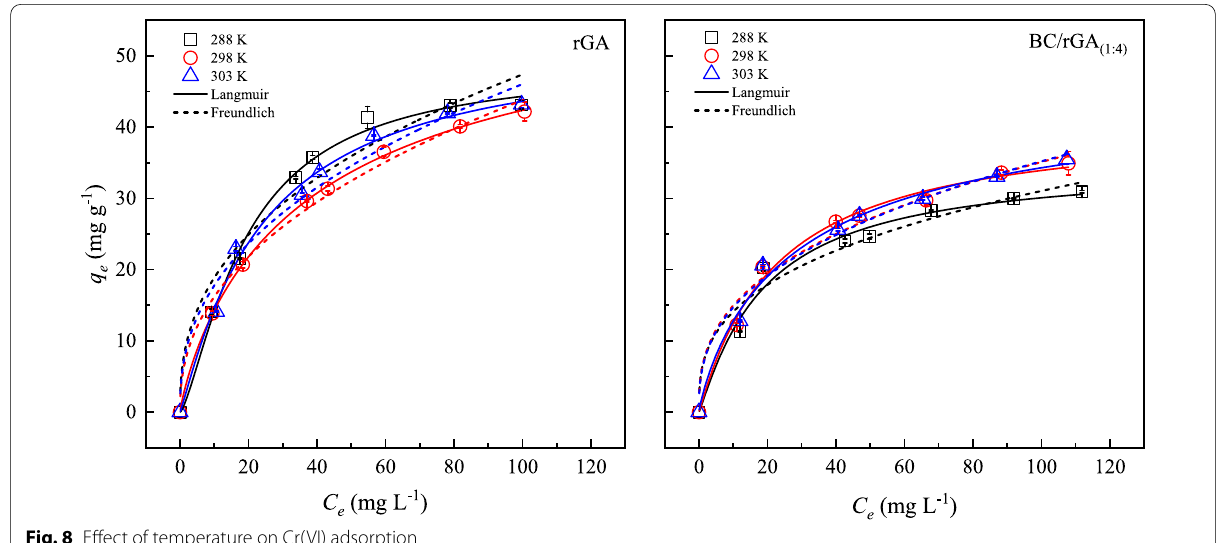
Fig. 8 Effect of temperature on Cr(VI)